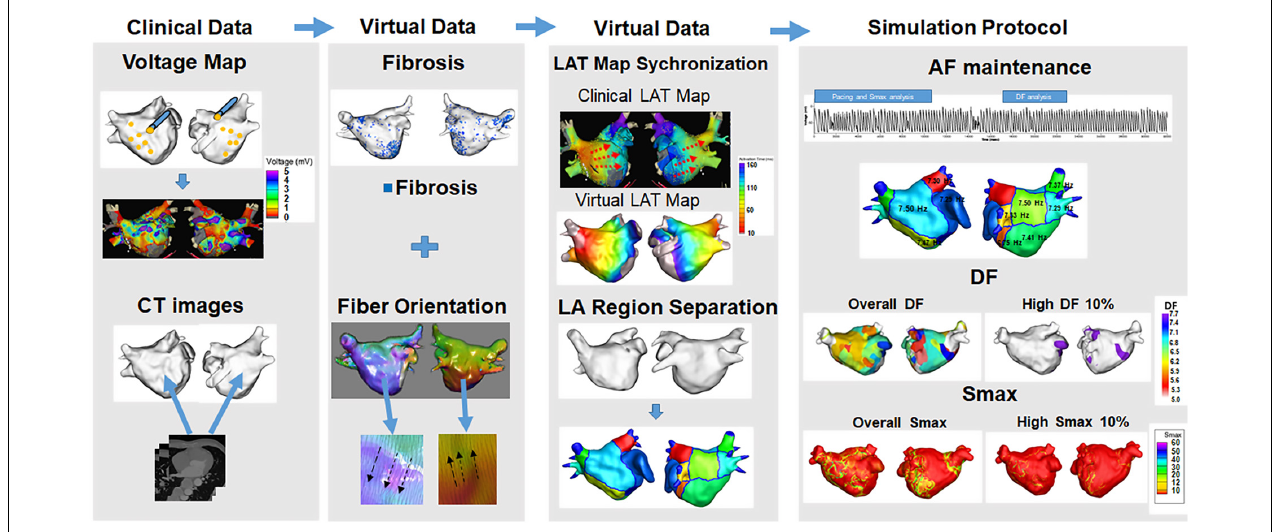
FIGURE 1 | Computational modeling of the left atrium with atrial fibrillation (AF). Realistic left atrium (LA) modeling was conducted using an interpolation of the voltage map and merging with the CT images. Fibrosis and the fiber orientation were implemented. The LAT map synchronization and AF simulation protocol were conducted for the